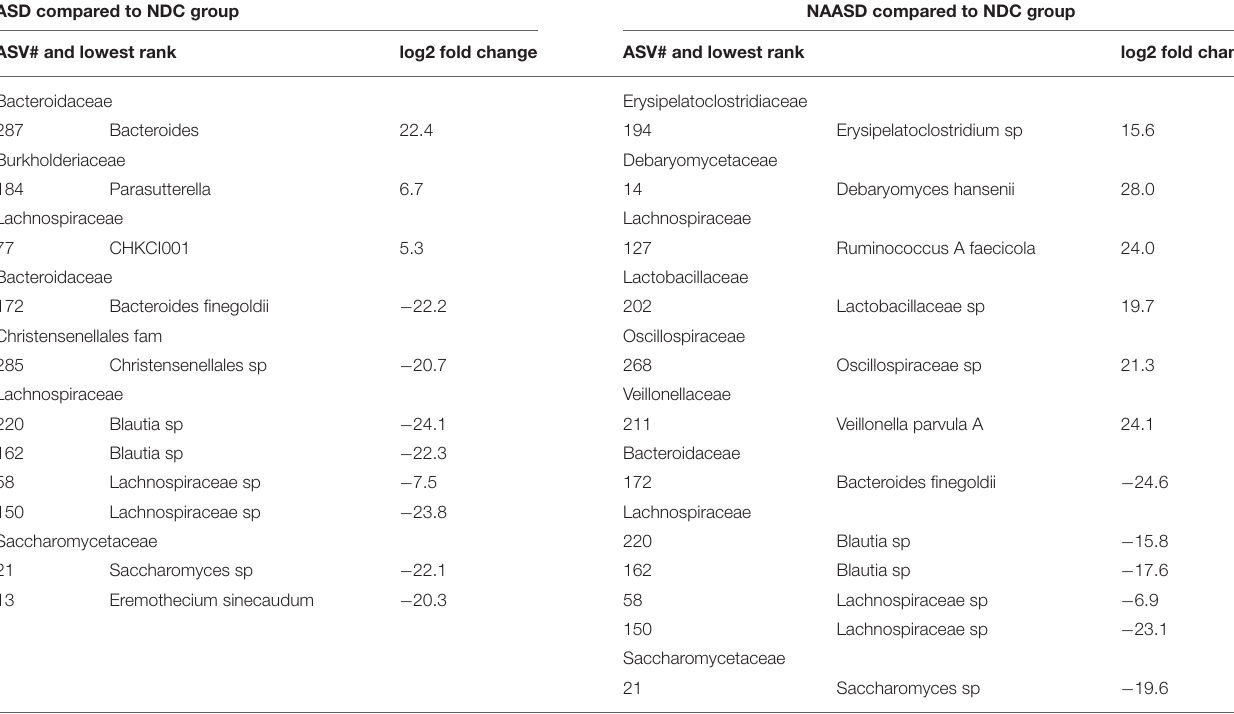
TABLE 3 | Bacterial and fungal ASV’s identified with DESeq2 as having significant changes in abundance between CSS groups. ASD compared to NDC group